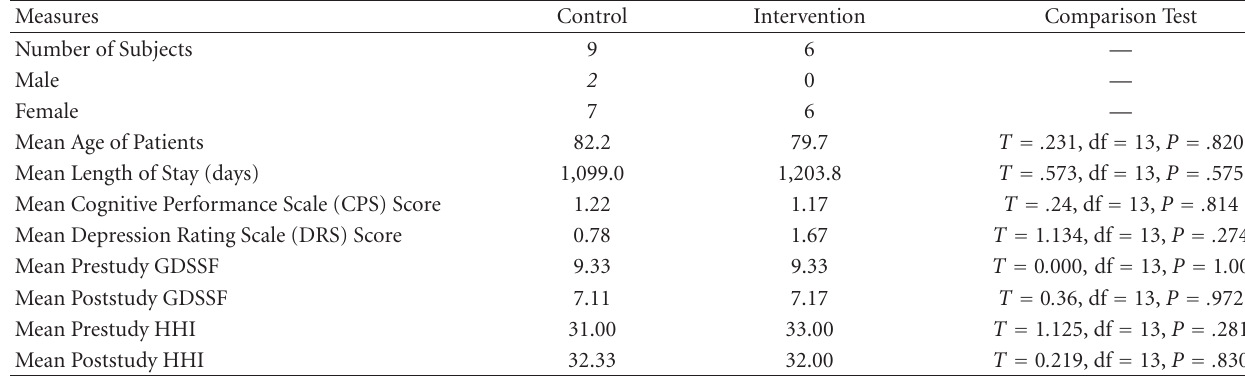
Table 1: Scores of control and intervention groups, with between-group comparisons.